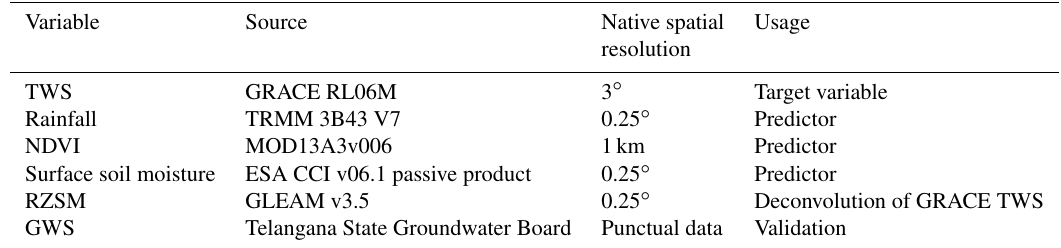
Table 2. Summary of all data used.